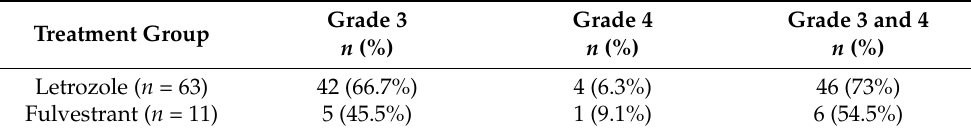
Table 2. Highest grade of neutropenia experienced by patients receiving palbociclib in combination with letrozole or